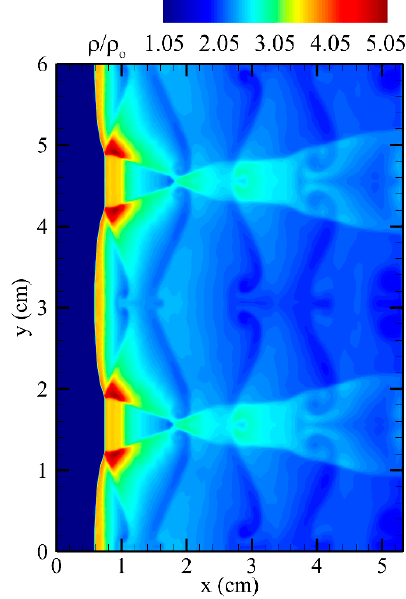
Figure 3. Weakly unstable detonation front observed in H 2 –O 2 mixtures with 85% argon dilution.